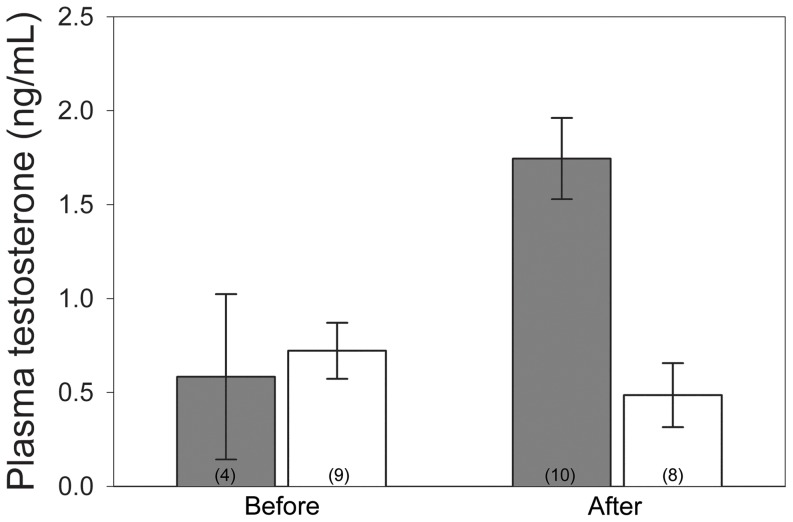
Plasma Testosterone.Experimental females (shaded bars) had significantly higher testosterone after implantation than before implantation. Experimental females also had significantly higher testosterone levels than control females (open bars). Sample sizes are shown in parentheses. These data are back-transformed from the natural log of plasma testosterone; error bars represent the standard error of these back-transformed means.